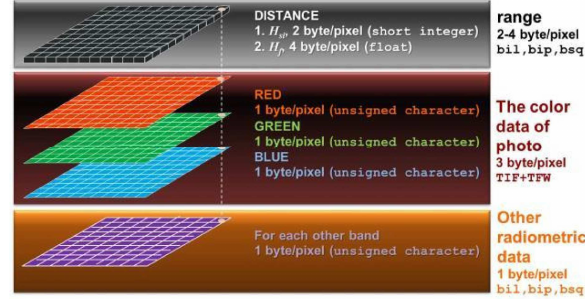
Figure 5. An isovist polygon, incorporating the visible area from a generating location (Turner et al.,